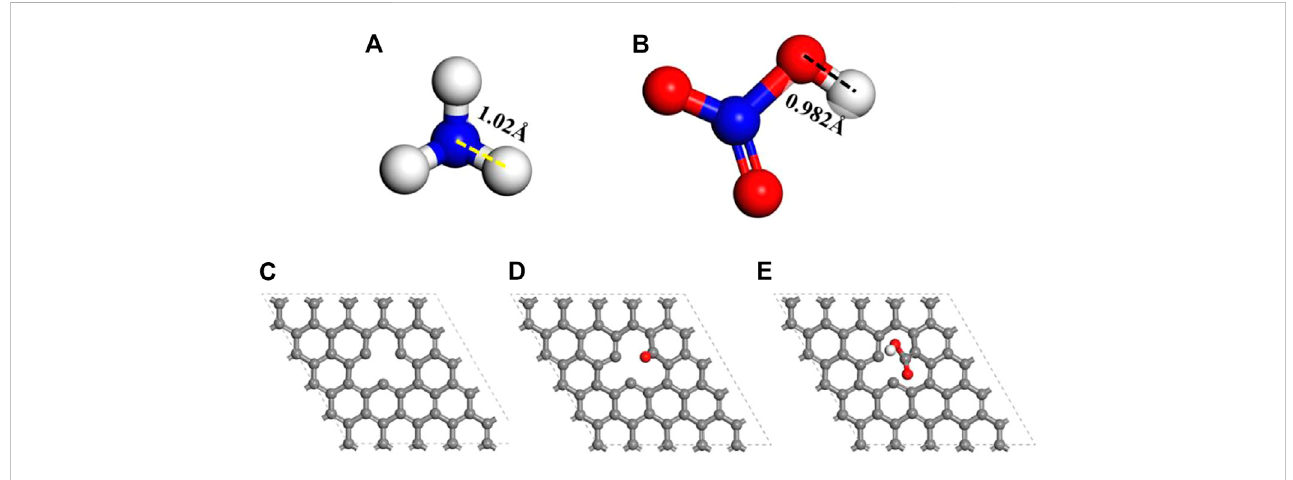
FIGURE 1 Geometricallyoptimizedcon fi gurationsofNH 3 (A) ,HNO 3 (B) ,defectedcarbon (C) ,defectedcarbonwithcarbonyl (D) anddefectedcarbonwithcarboxyl (E) from the top view. (Only the top layer is displayed. Atomic legend: -C , -H , -O ,